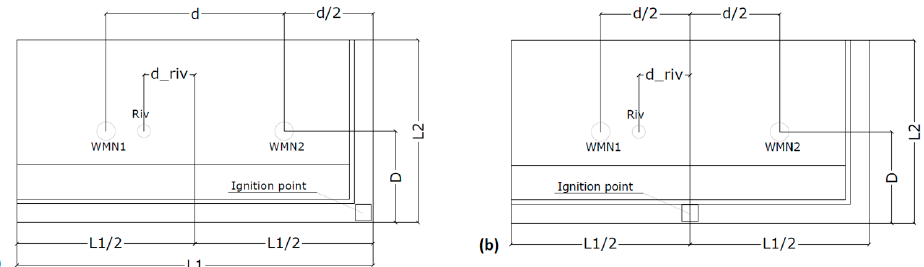
Figure 1. Plan view of the test chamber: ( a ) ignition source at the corner behind benches (configura- tion C1); ( b ) ignition source at the center of the wall behind the benches (configuration C2); WMN : water-mist nozzle location, Riv : heat-detector location.